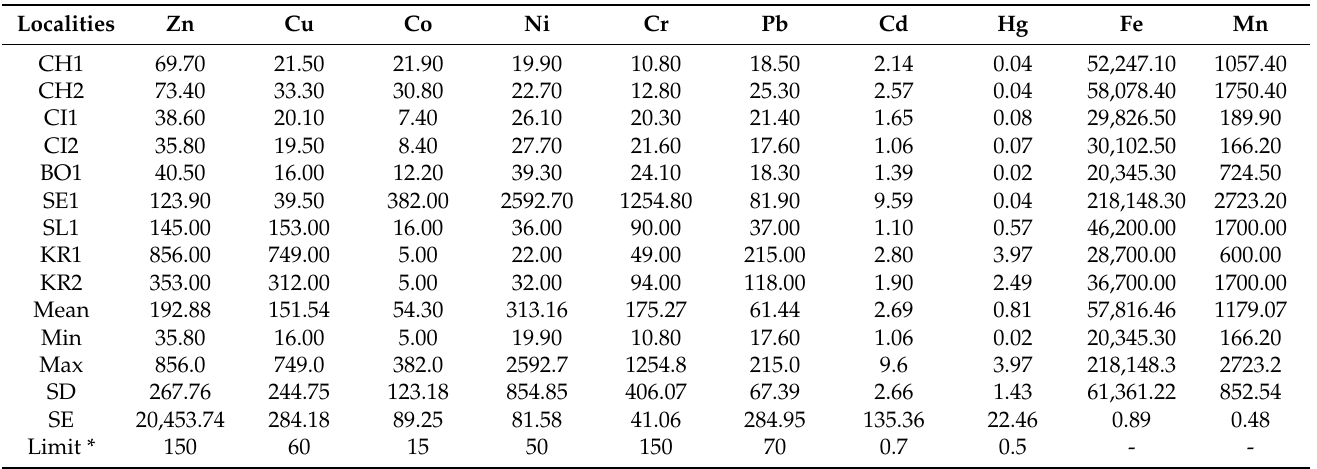
Table 2. Content of risk elements (mg/kg) in the soils of the studied localities expressed by descriptive statistics.